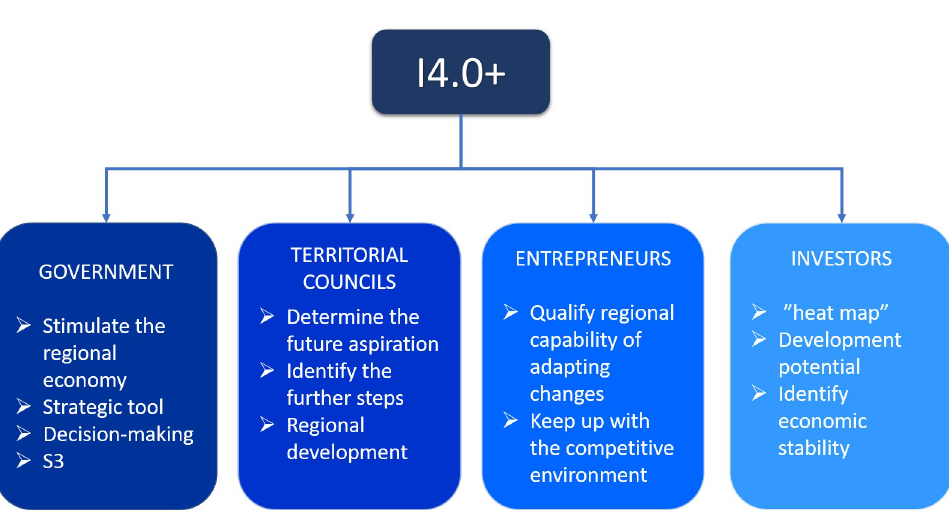
Fig 2. Possible areas of application of the I4.0+ index to utilize the potential in terms of regional strength.